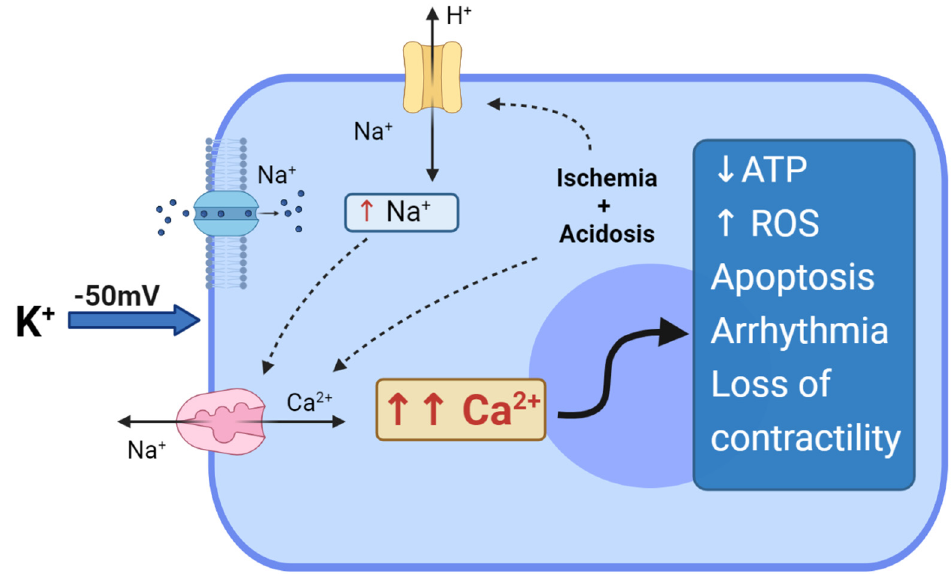
Figure 1. Depolarized arrest and hyperkalemia cytotoxicity.Effect of hyperkalemia and prolonged myocardial membrane depolarization at − 50 mV. Na+ entry through the “window current”, which induces reversal of the Na + /Ca 2+ exchanger with the entry of Ca 2+ into the cell. Regional ischemia and metabolic acidosis can further impact Ca 2+ loading, with increases in intracellular H + , thus activating the Na+/H+ exchanger; the Na+/H+ exchanger induces further activation of Na + /Ca 2+ exchangers, exacerbating Ca 2+ overloading in the myocyte. The entire cascade can induce depletion of ATP, generation of ROS, cell apoptosis, arrhythmias and loss of contractility.